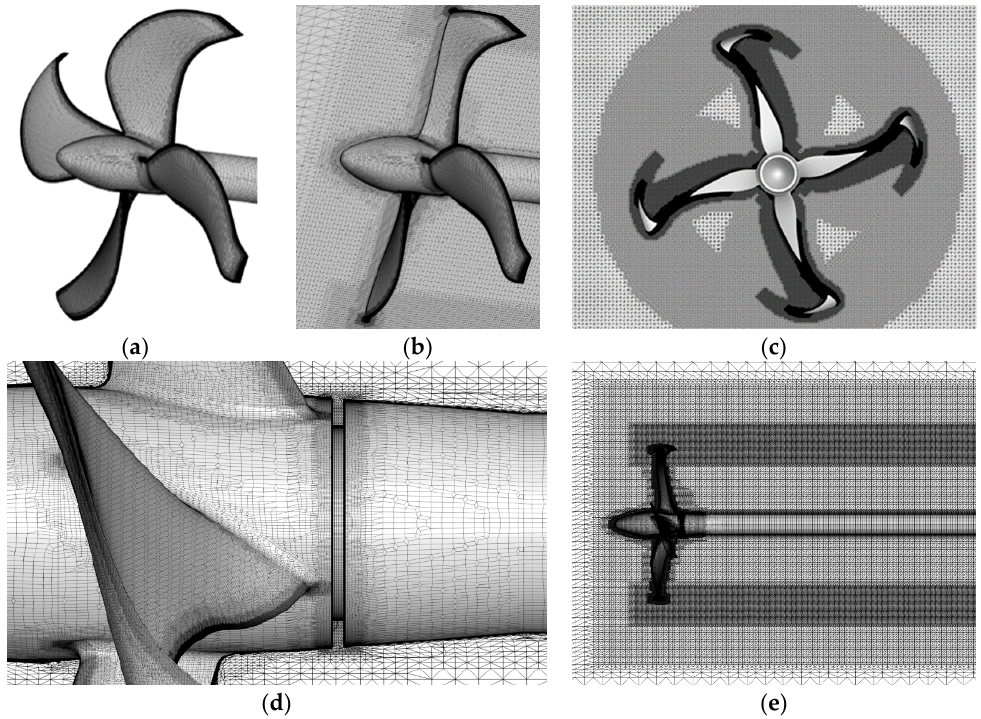
Figure 4. Computational mesh. ( a ): computational mesh on the propeller; ( b ): longitudinal cut on the computational grid; ( c ): cross section on the grid in the geometric center of the propeller; ( d ): detailed view of the grid around the dynamometer clearance; ( e ): grid in the wake of the propeller.